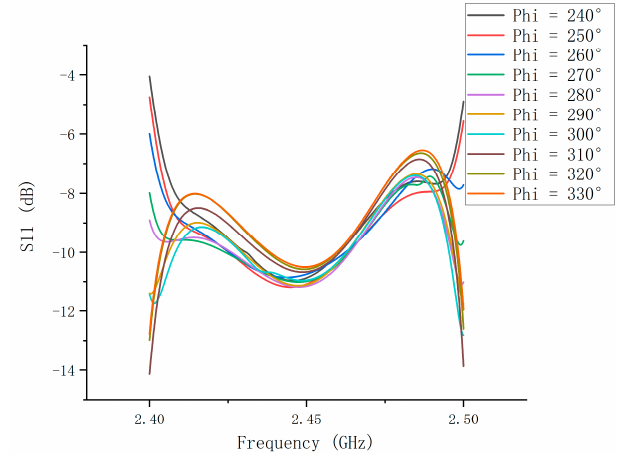
Figure 6. Comparison of different phi values of S11.